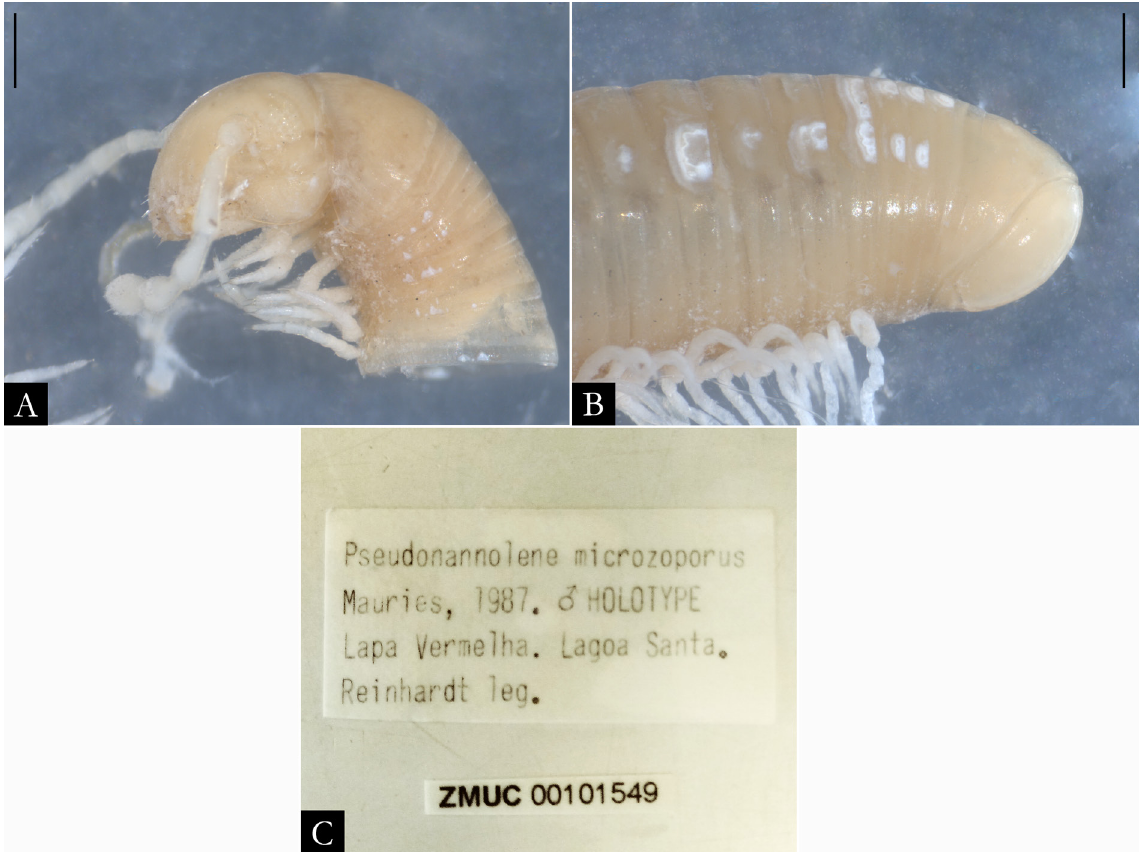
Fig. 97. Pseudonannolene microzoporus Mauriès, 1987, holotype, ♂ (NHMD), in lateral view. A . Anterior region. B . Posterior region. C . Original label of type material. Scale bars = 0.5 mm.